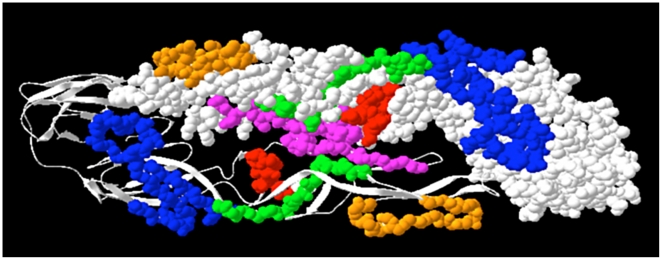
Top view of the homology model of the DENV-3seq E-glycoprotein dimer and location of the eleven mapped peptides.Peptides are represented in colorful space-filling: peptide 11 in green, peptides 15 and 16 in orange, peptides 27, 28, 29, 30, 31 e 32 in blue, 40 in red and 50 in violet. For illustrative reasons one monomer is represented as space-filling and the other as ribbons.